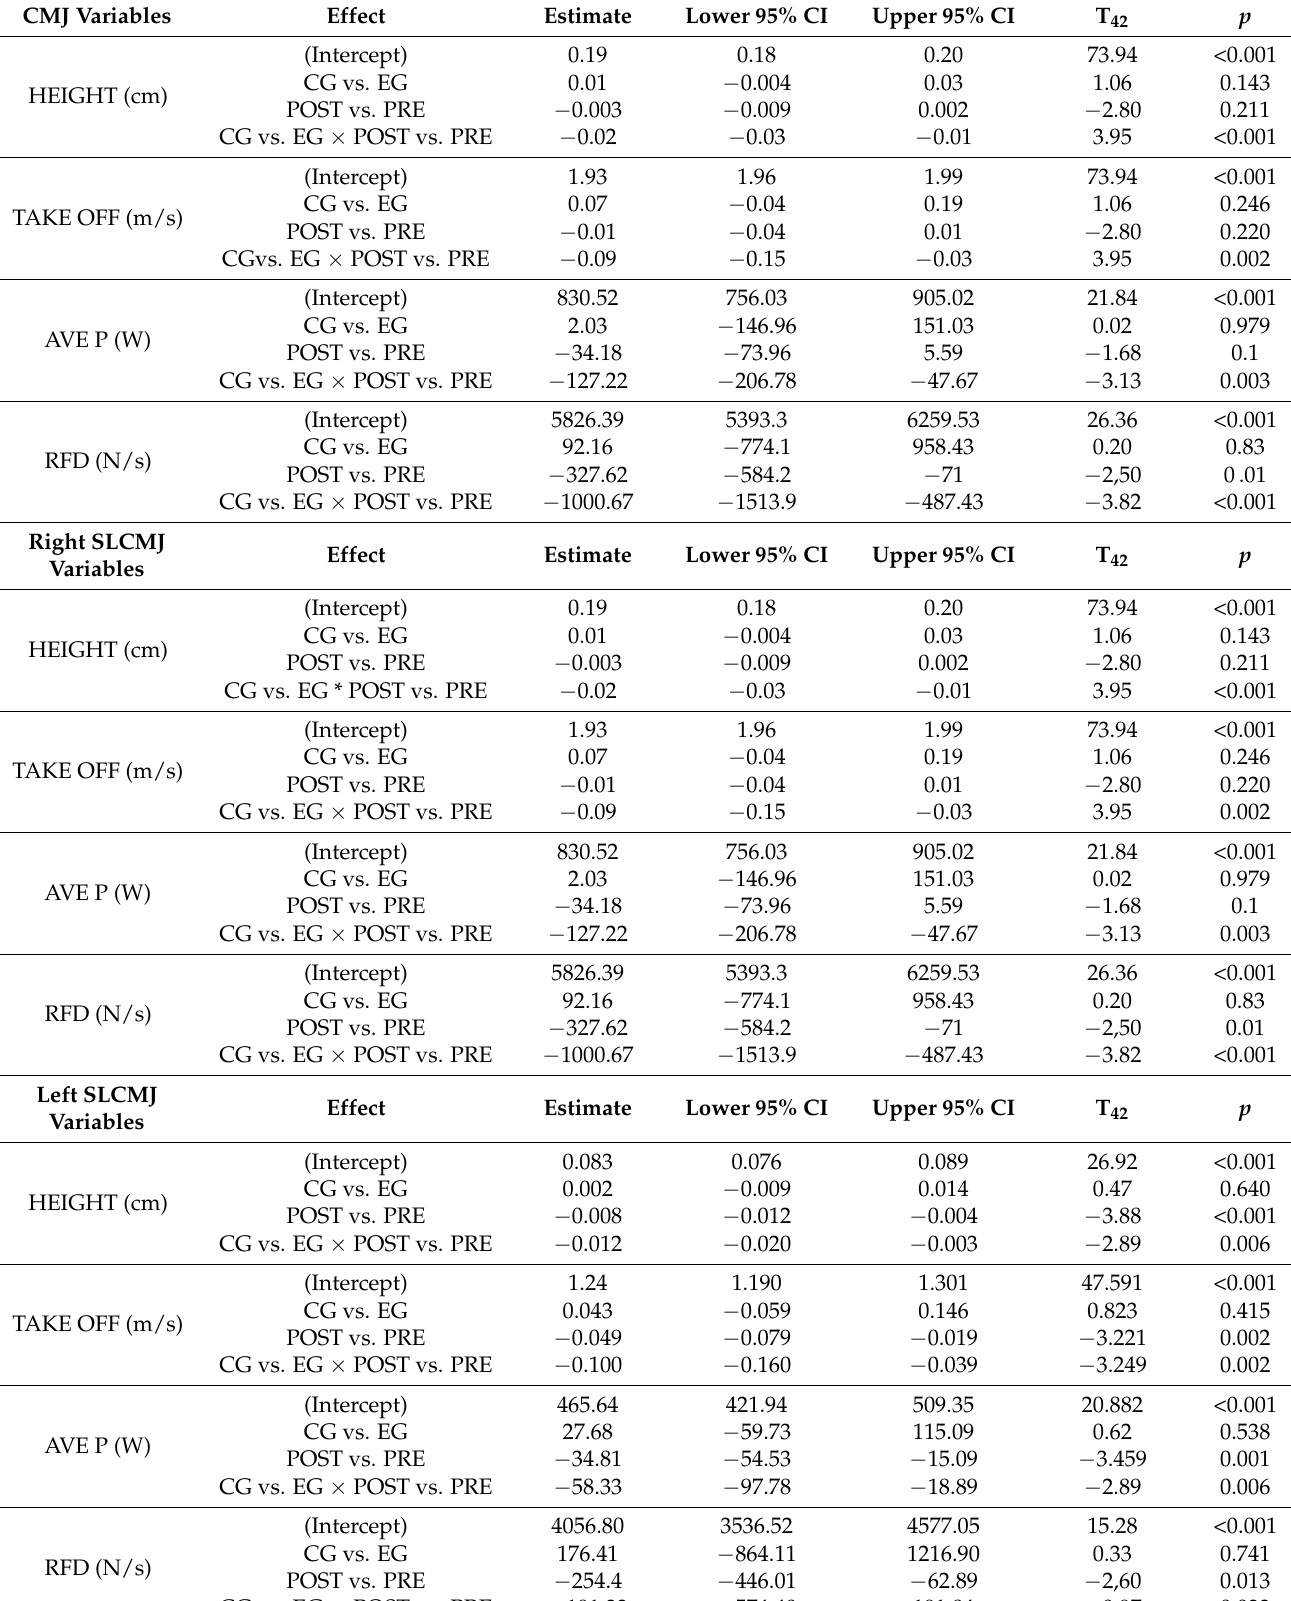
Table 3. Fixed effects of the CMJ and SLCMJ